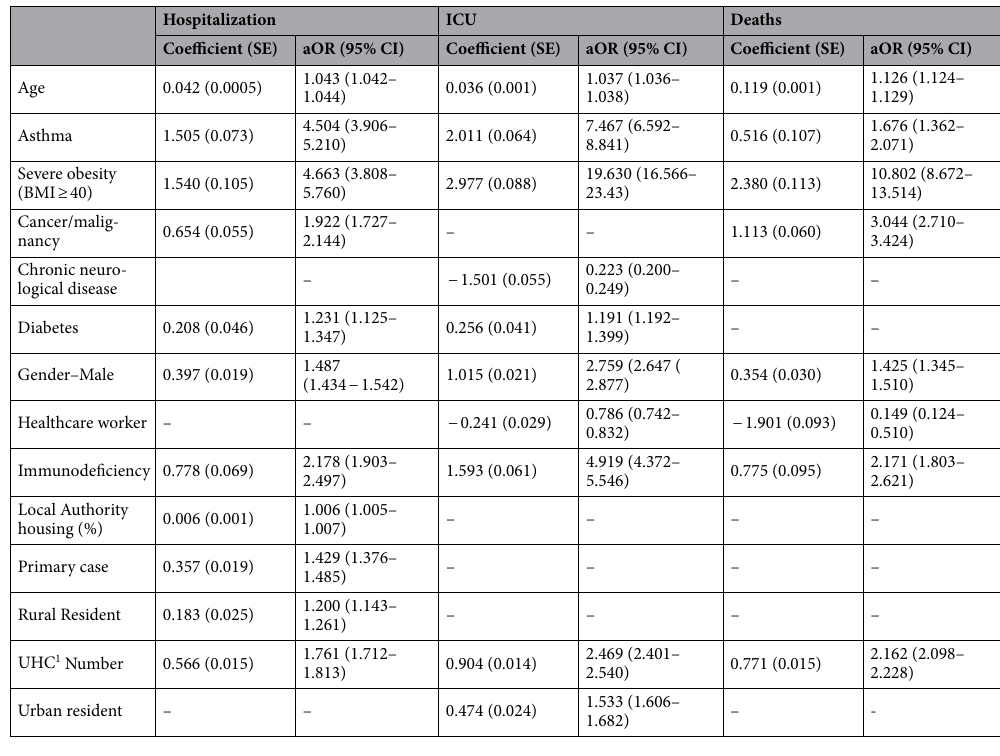
Table 3. Generalised linear models predicting hospitalization, intensive care unit admission and mortality among symptomatic COVID-19 patients in the Republic of Ireland, February 29th to November 30th 2020 (N = 47,265). 1 Underlying health condition.